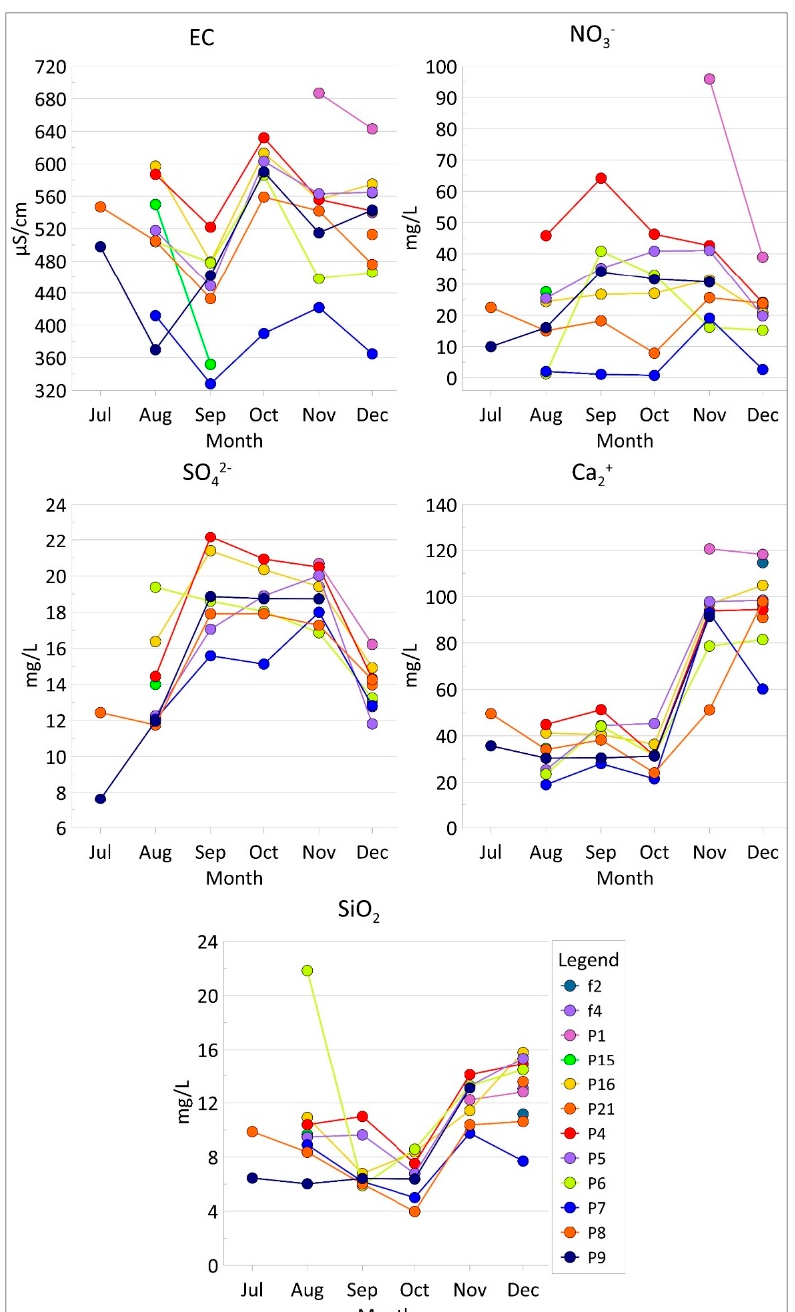
Figure 9. Main physico-chemical parameters of groundwater in the study site. EC is characterized by high fluctuations (min = 328 µ S / cm, mean = 515 µ S / cm, max = 687 µ S / cm), + with higher values in autumn. Among the analyzed cations, only Ca 2 varied throughout the sampling periods (min = 18.96, mean = 64.9, max = 120.51 mg / L), with lower values during summer and higher concentrations in November and December. Within the analyzed anions, only sulphate (min = 7.63, mean = 16.25, max = 22.18 mg / L) and nitrate (min = 0.79, mean = 26.59, max = 95.94 mg / L) varied − seasonally. SO 42 concentrations were marked by lower values during the irrigation period and displayed higher concentrations from September to